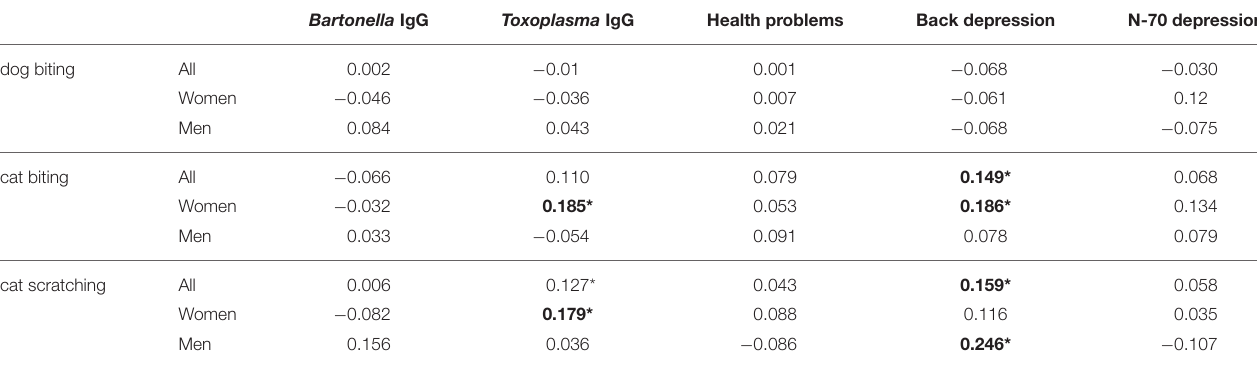
TABLE 6 | Association between animal-related injuries pathogens’ seropositivity and mental and physical